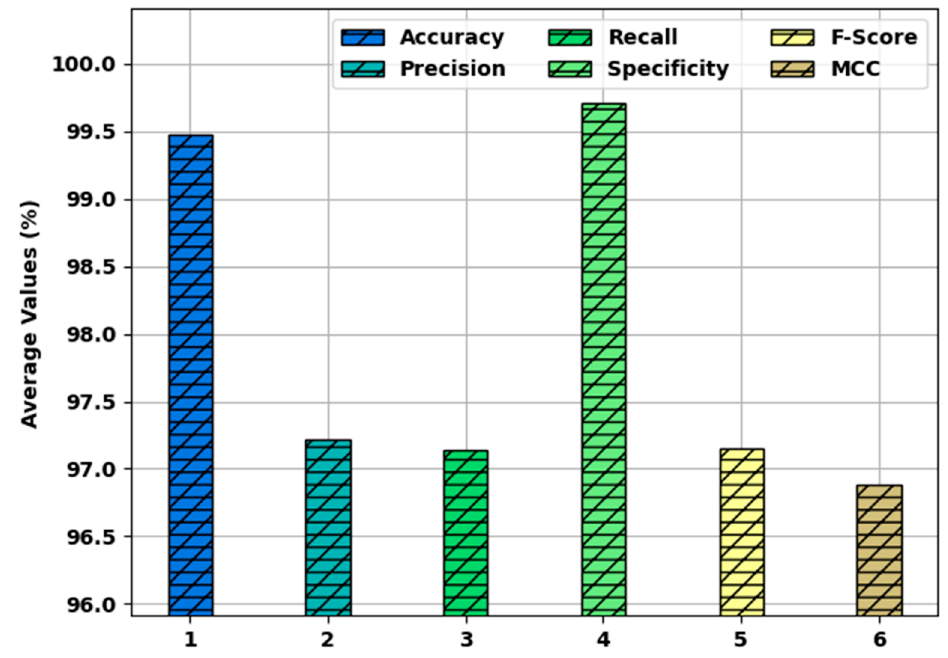
Figure 7. Average analysis of SFODLD-SAC technique on 70% of TRS. Table 4 provides the detailed classification outcomes of the SFODLD-SAC model on 30% of TSS. Figure 8 showcases a comparative result of the SFODLD-SAC model on 30% of TSS in terms of accu y , prec n , and reca l . The figure exhibits that the SFODLD-SAC technique attained improved performance under all class labels. For instance, the SFODLD- SAC model recognized class 0 with accu y , prec n , and reca l of 99.52, 96.05, and 98.65%, respectively. Moreover, the SFODLD-SAC method identified class 5 with accu y , prec n , and reca l of 99.76, 98.57, and 98.57%, respectively. Furthermore, the SFODLD-SAC model